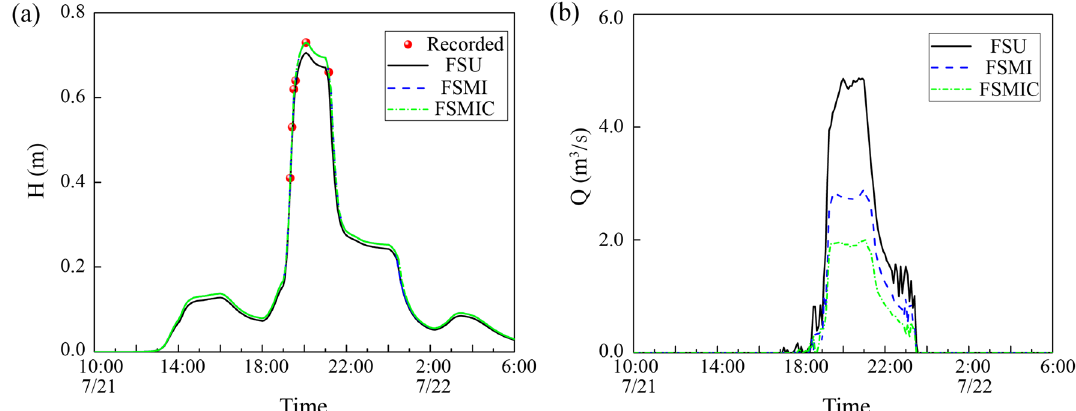
Figure 12. Comparison of the three FS methods. ( a ) Recorded point water depth. ( b ) M98 overflow discharge. The black solid line, the blue dash line, and the green short dash dot line respectively express the computed values of the FSU, FSMI, and FSMIC methods. The red point expresses the recorded water depth in the 721 rainfall event.